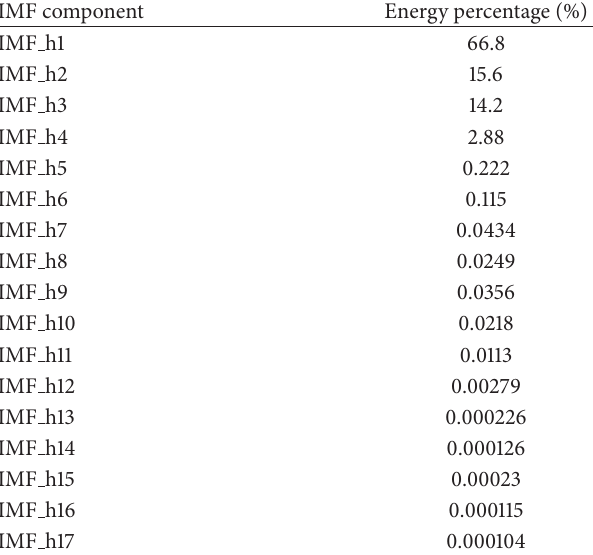
Table 14: IMF component energy percentages of effective micro- seism signals by EEMD in working condition